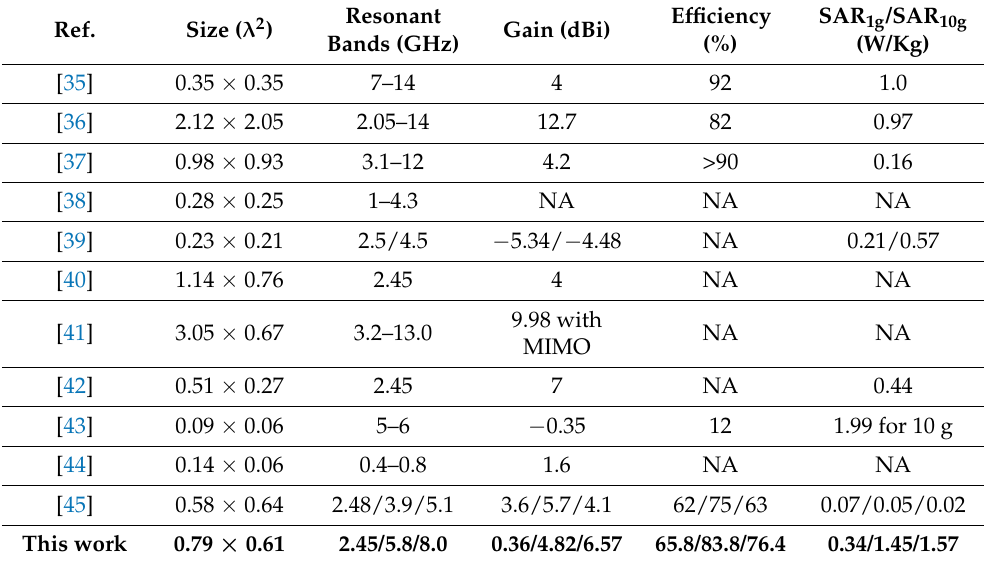
Table 4. Comparison of the proposed antenna to other antennas having kapton polyimide substrate.